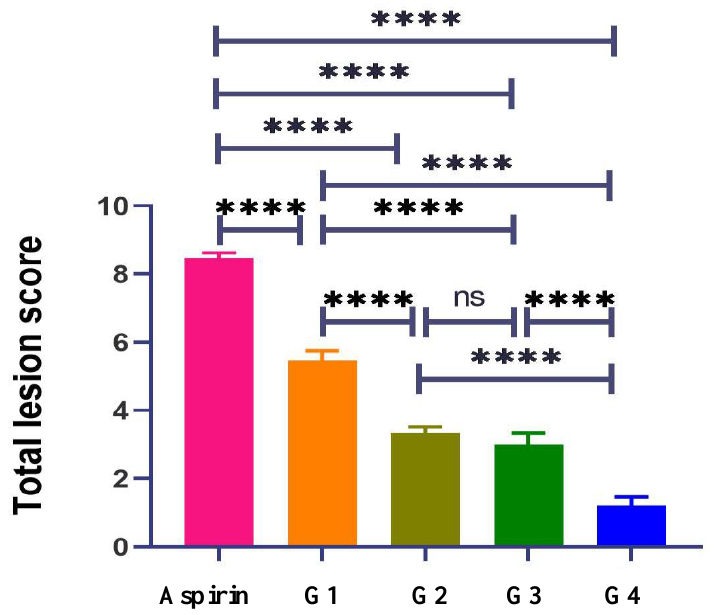
Figure 22. Total histologic score. Data were presented as means ± SE. **** p ≤ 0.0001. Significance was considered at p ˂ 0.05. ns-not significant.